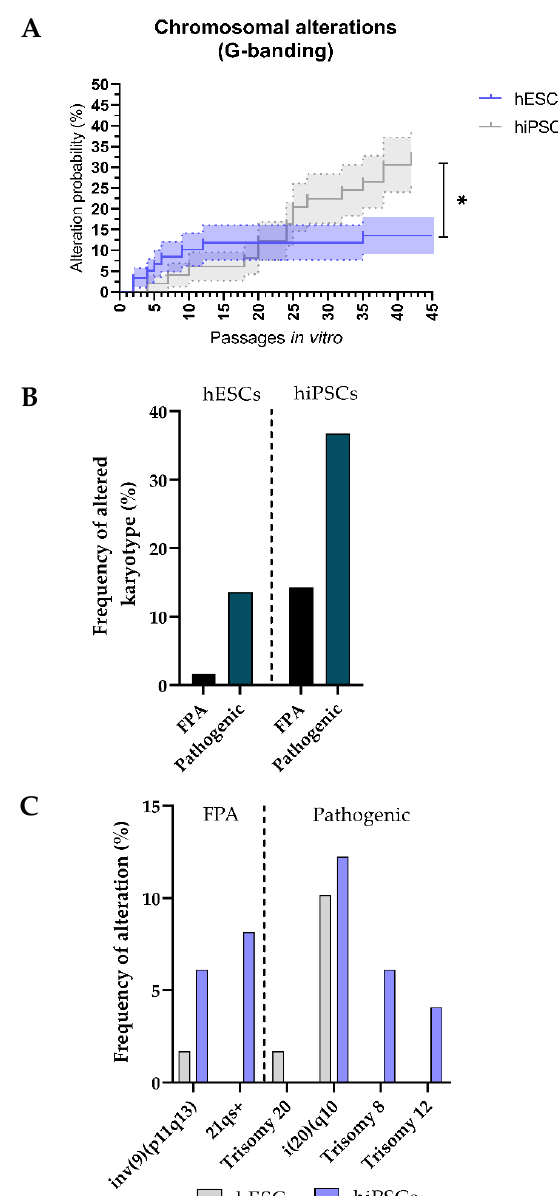
Figure 4. The hiPSCs lines show a higher prevalence of karyotype genomic aberrations detected by G-banding as compared to hESCs: ( A ) Survival analysis (Kaplan – Meier curves) of the evolution of the probability (%) of hESCs and hiPSCs being affected by chromosomal genomic alterations de- tected by G-banding over time (passages in vitro). Error bars represent standard error of the mean (s.e.m.); ( B ) bar graph of percentage of frequency of all alterations found in hESCs compared with hiPSCs on a total number of 108 karyotypes performed; ( C ) histogram showing the frequency at which different types of FPAs and pathologic alterations are detected in hESCs and hiPSCs via kar- yotype. FPA: Frequent Polymorphic Alterations.